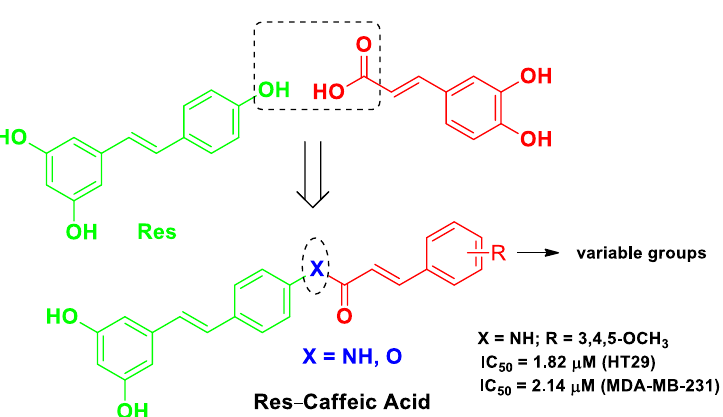
Figure 10. Structure and activity of the most potent hybrid compound developed by Li et al. [51].